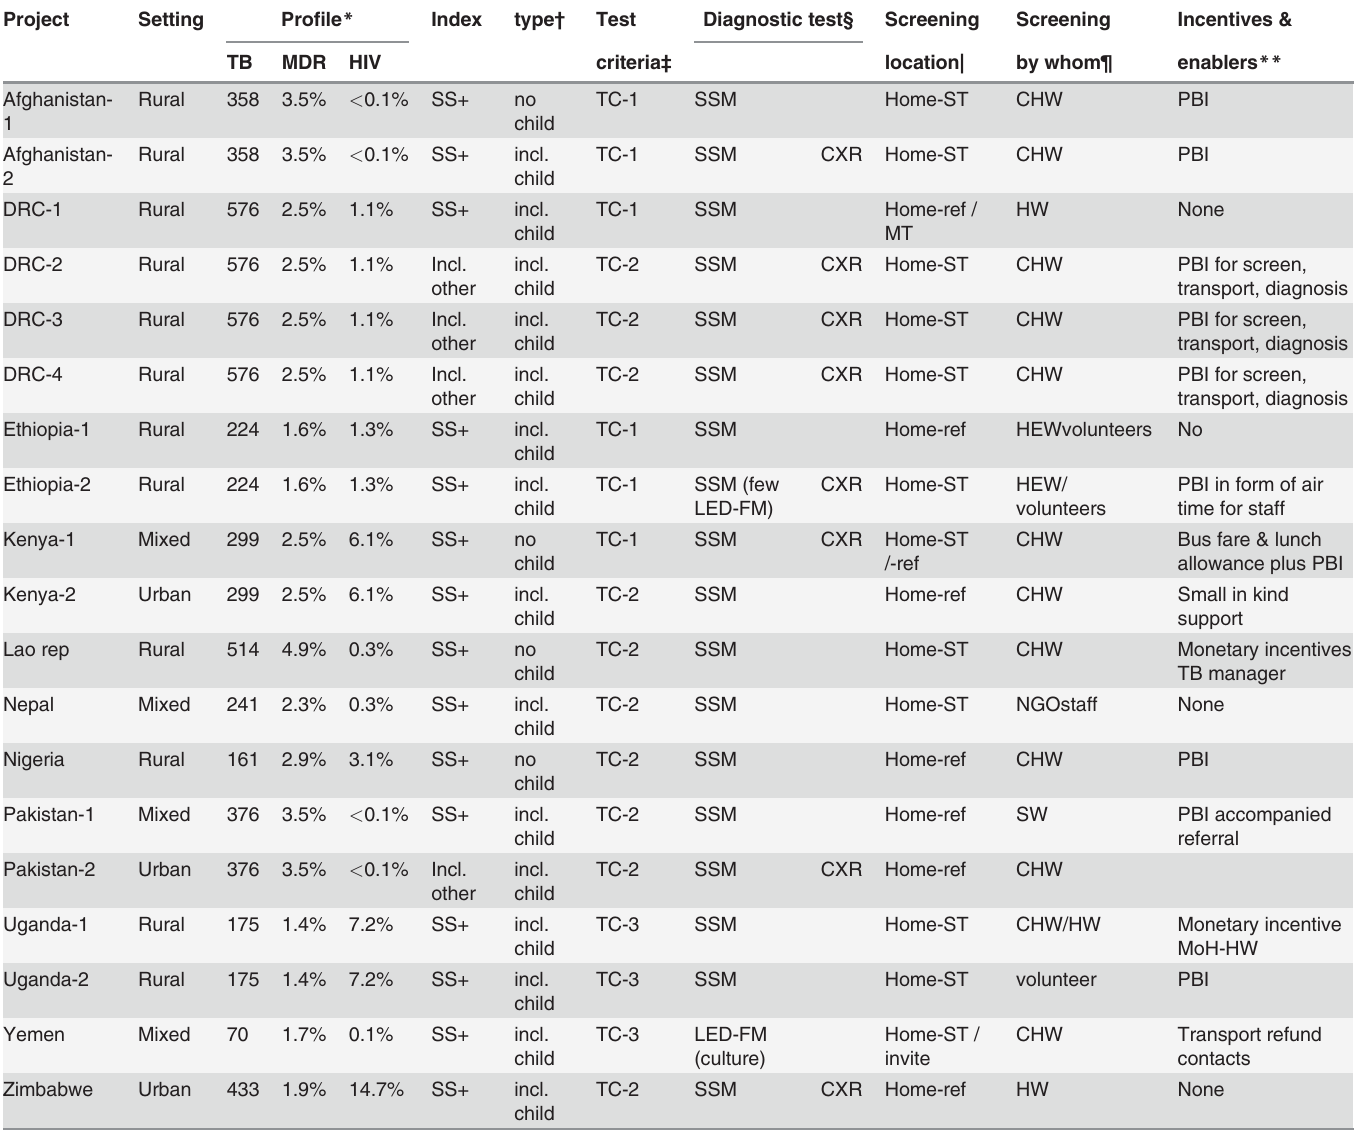
Table 1. Description of intervention setting, screening approaches and de fi